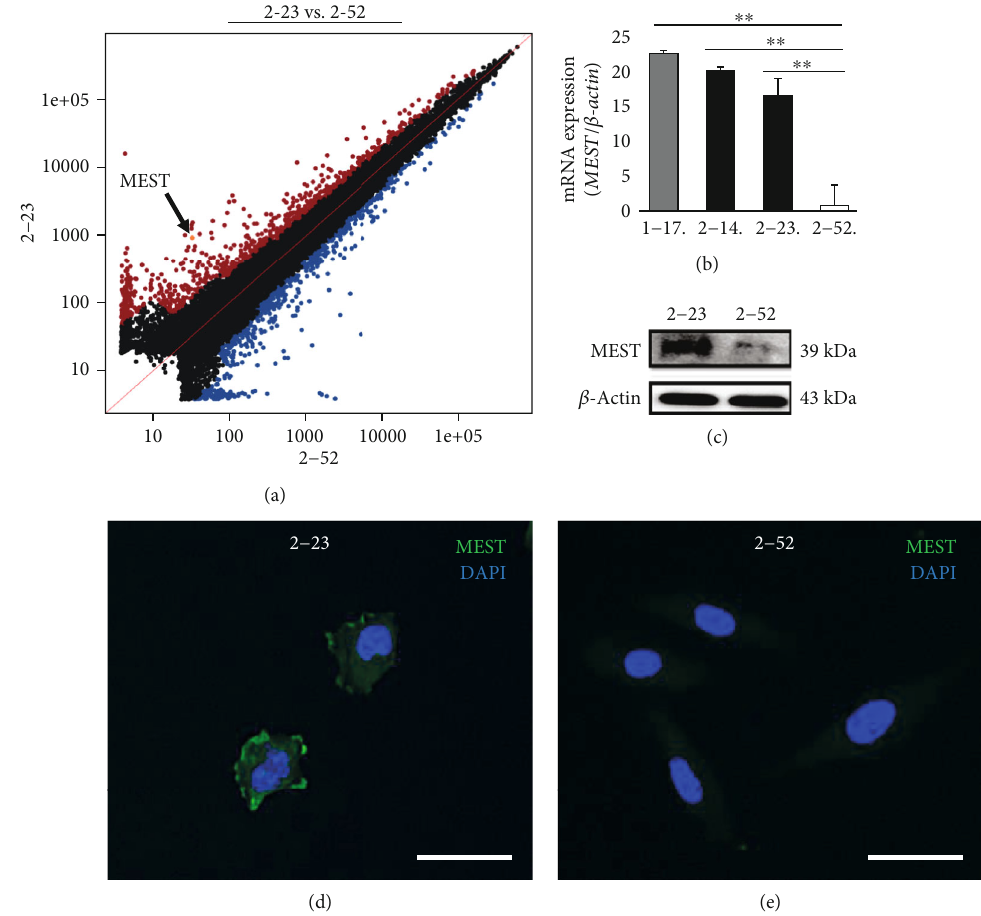
Figure 2: The expression of MEST in human PDLSC lines. (a) Scatterplots representing the expression of genes in 2-23 and 2-52 cells in microarray analysis. (b) The expression of MEST mRNA in 1-17 (grey column), 2-14 (left black column), 2-23 (right black column), and 2-52 (white column) cells was assessed by quantitative RT-PCR. It was normalized against β -actin expression. All values are means ± S : D : (error bars) of quadruplicate assays. ∗∗ p < 0 : 01 . (c) The expression of MEST protein in 2-23 and 2-52 cells was assessed by western blot analyses. It was normalized against β -actin expression. (d, e) The localization of MEST in 2-23 (d) and 2-52 (e) cells was examined by immuno fl uorescence staining (anti-MEST: green, DAPI: blue; bars: 20 μ